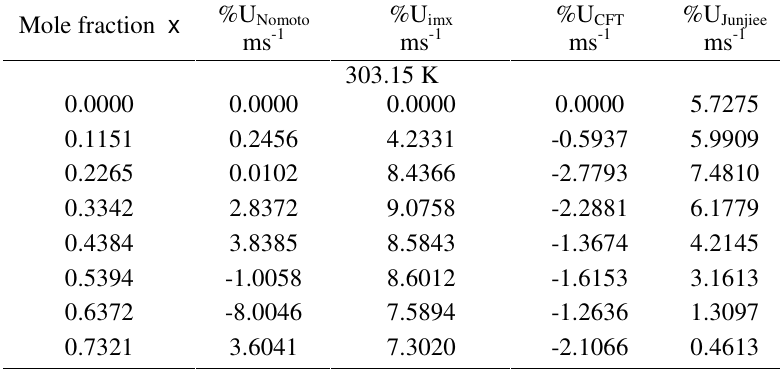
Table 2. Percentage deviation between experimental and theoretical values of velocities in anisaldehyde + toluene system at different